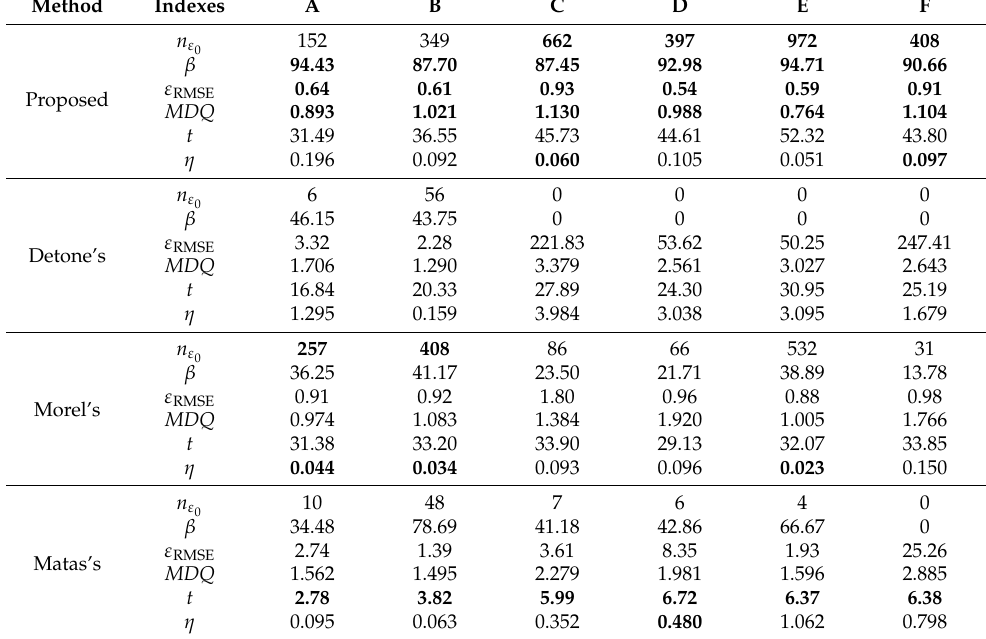
Figure 13. The chessboard registration results of four comparison approaches for image pair A. ( a ) Registration image of proposed, ( b ) registration image of Detone’s, ( c ) registration image of Morel’s, and ( d ) registration image of Matas’s. Subregions I and II display the detailed view. Table 7. Quantitative comparison of four methods based on six groups of image pairs. In this table, n ε is the number of correct matches (pair), β is the correct ratio (%) of matches, ε RMSE is the matching 0 error (pixels), MDQ is the matching distribution quality, t is the total test time (second), and η is the matching efficiency (the unit is second per pair of matching points). The best score of each index is displayed in a bold